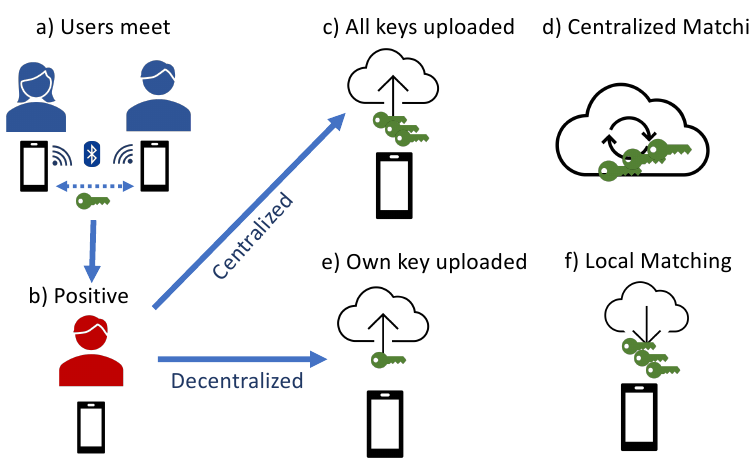
Figure 1. Centralized vs. decentralized contact tracing approaches: ( a ) when two users’ smartphones are in range, they exchange their anonymous key codes; ( b ) when an individual is detected as positive, he/she notifies the application of his/her this new status; in the centralized approach ( c ), the smartphone uploads its key and also the other keys gathered from its previous contacts; ( d ) the possible risk contacts are detected using the centralized servers; in the decentralized approach ( e ), the smartphone only uploads its key; and ( f ) all keys of detected positives are downloaded by the application and the matching is performed